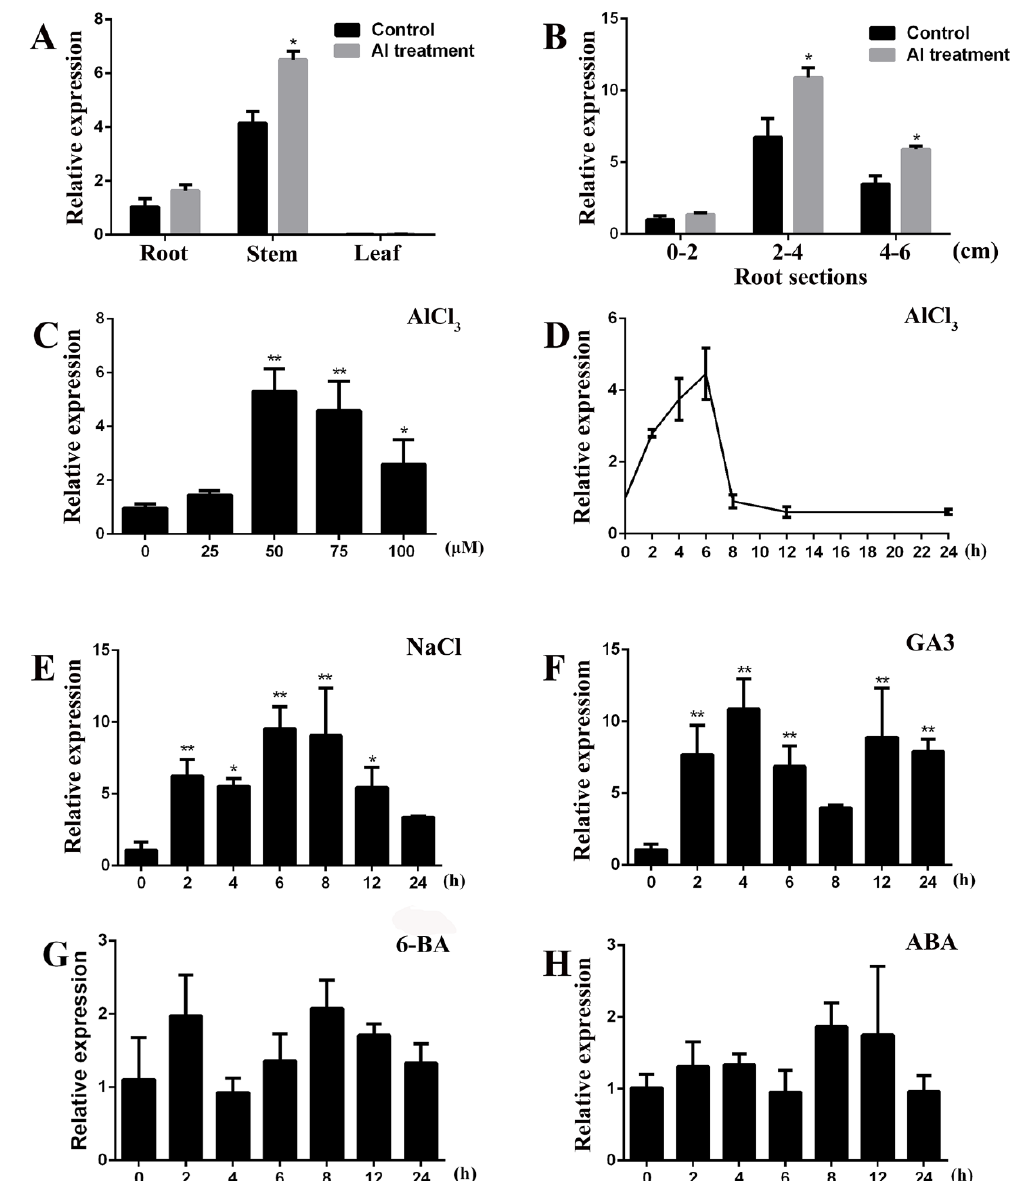
Figure 3. Expression characteristics of GsGIS3. ( A ) GsGIS3 expression levels in root, stem, and leaf of Glycine soja. ( B ) Expression levels of GsGIS3 in Glycine soja roots in different sections. ( C ) Pattern of GsGIS3 expression under Al concentration gradients. ( D ) Temporal expression pattern of GsGIS3 under acidic aluminum exposure. ( E – H ) Patterns of GsGIS3 expression under the different conditions of abiotic stresses: 200 mM NaCl ( E ); 100 μM GA3 ( F ); 100 μM 6BA ( G ); and 10 μM abscisic acid (ABA) ( H ). GsGIS3 transcript abundance was assessed by qRT-PCR using the 2 –ΔΔCt method with the actin Actin3 gene as an internal control [40]. The data are represented as the averages of three independent biological experiments ± SD, and asterisks indicate a significant difference (* P < 0.05; * P < 0.01) compared with the corresponding controls.